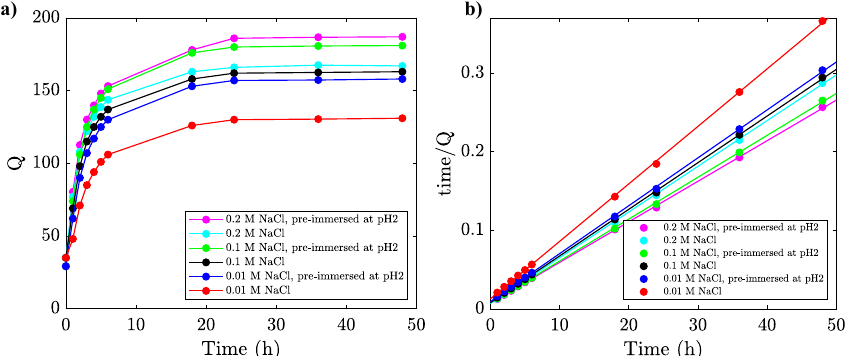
Figure 4. ( a ) Degree of swelling Q versus time t in aqueous solutions of NaCl. Circles: experimental data, solid lines: guides for eye. ( b ) Approximation of the experimental data by Equation